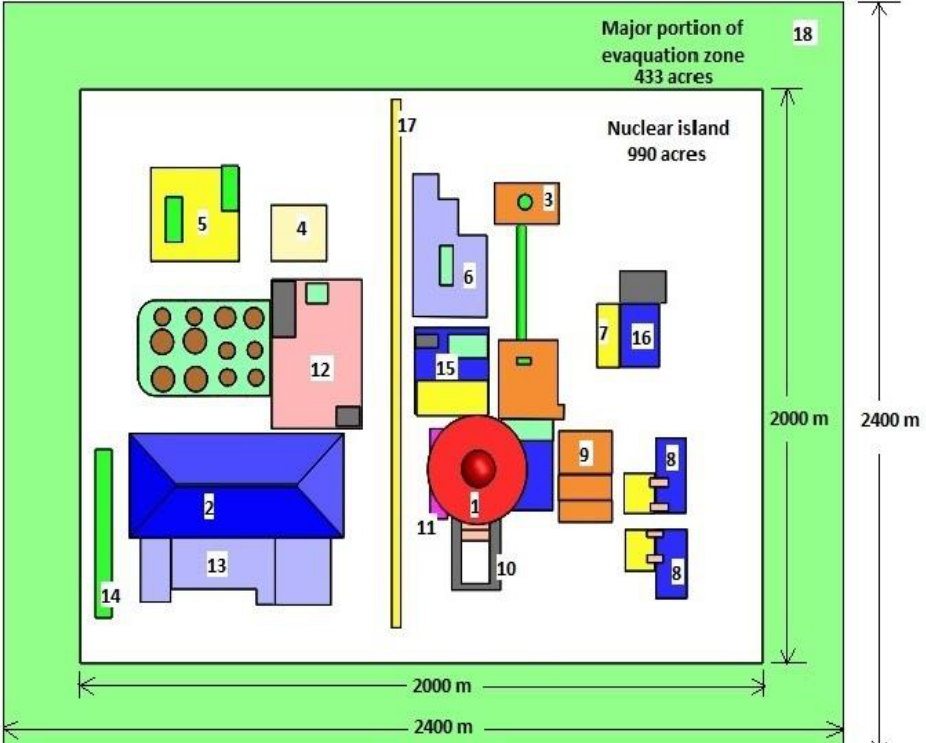
Figure 4: A Typical 1200 MW NPP with Solar